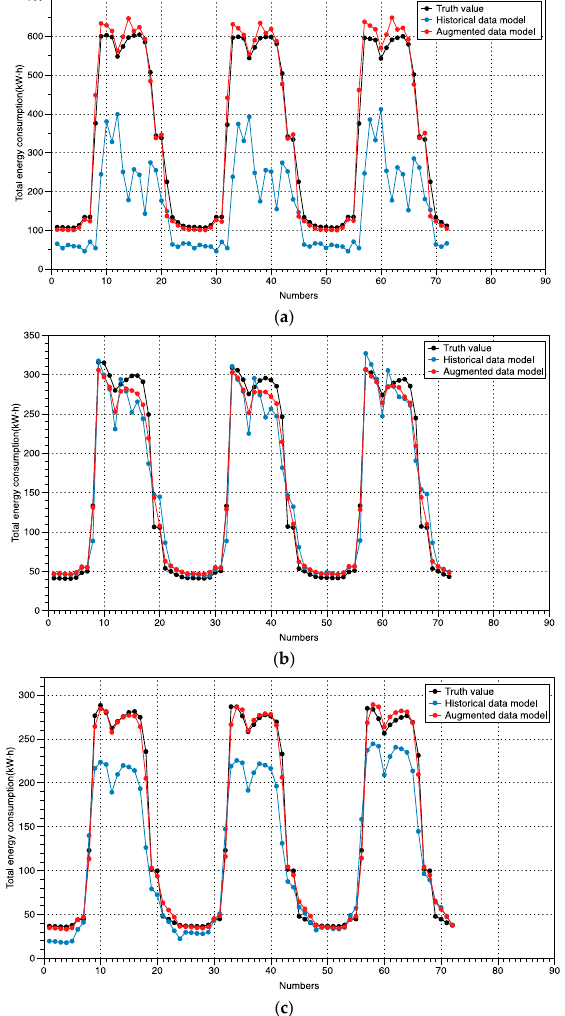
Figure 13. Predicted results of two different models: ( a ) Scenario 1; ( b ) Scenario 2; ( c ) Scenario 3.